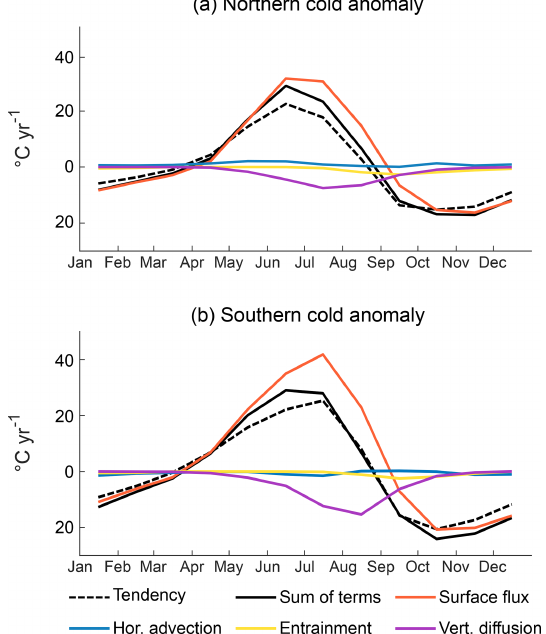
Figure A3. The average seasonal cycle in the dominant terms of the mixed-layer temperature budget averaged over the northern (53–63 ◦ N, 50–20 ◦ W; a ) and southern (43–53 ◦ N, 50–20 ◦ W; b ) half of the cold anomaly region ( ◦ Cyr − 1 ) for ECCOv4-r4. The model temperature tendency is shown by the dashed black line and the sum of the temperature budget terms driving the change in temperature by the solid black line. The remaining lines represent these individual terms: the surface heat flux (orange), horizontal advection (blue), vertical entrainment (yellow), and vertical diffusion (purple).